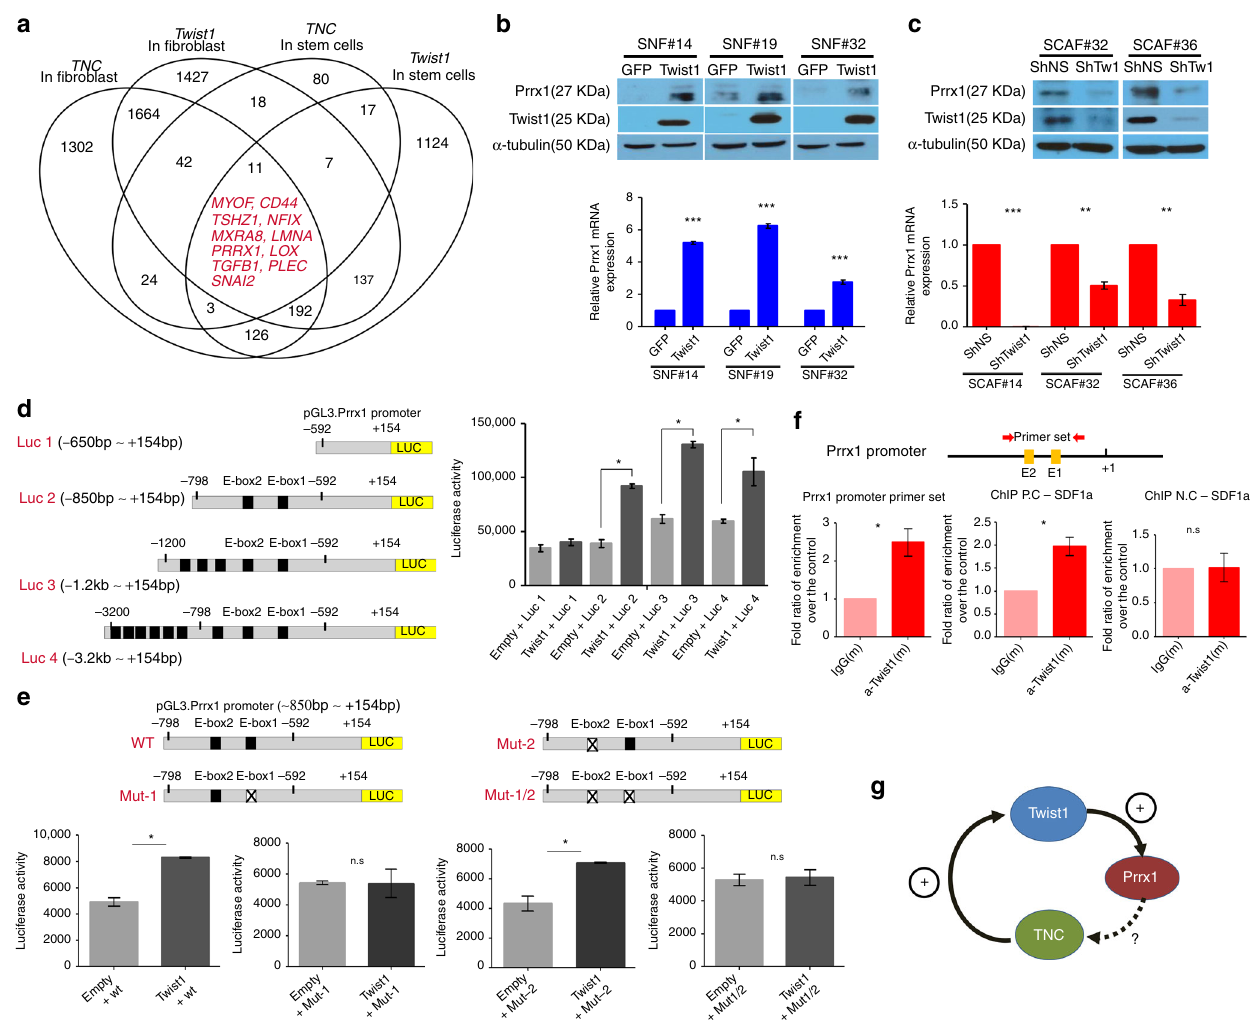
Fig. 2 Twist1 was an essential, positive transcriptional regulator of Prrx1 expression in both normal fi broblasts and CAFs. Twist1 enhanced the expression of Prrx1, a potential TNC inducer, by direct transcriptional activation. a Analysis of the FANTOM database revealed 11 candidate genes whose expressions were signi fi cantly correlated with both Twist1 and TNC expression in fi broblasts and stem cells. b Induction of Twist1 expression increased Prrx1 expression in normal fi broblasts. c The knockdown of Twist1 expression in CAFs led to decreased Prrx1 expression. Data are presented as the mean ± SEM; N = 3 independent experiments (two-tailed t test: ** p <0.001, *** p <0.0001). d To determine whether Twist1 regulates Prrx1 promoter activity, Prrx1 promoter- driven luciferase gene and Twist1 expression vector were cotransfected into HT1080 fi brosarcoma cells. The luciferase reporter assay revealed that the ectopic expression of Twist1 increased the Prrx1 promoter activity. Of the four different Prrx1 promoter constructs, construct #2 containing two E-boxes between − 798 and − 592 bp from the TSS of Prrx1 showed the most obvious difference in response to transient cotransfection with a Twist1 expression vector. Data are presented as the mean ± SEM; N = 3 independent experiments (two-tailed t test: * p <0.001). e Two E-box mutations in E-box 1 (CATCTG ( − 619) to GGTCTG) and E-box 2 (CAACTG ( − 787) to TCACTG) were introduced in HT1080 cells. The Twist1-induced Prrx1 promoter activity was negated by the E-box mutation that was located at 619 bp of the TSS of Prrx1. Data are presented as the mean ± SEM; N = 3 independent experiments (two-tailed t test: * p <0.05). f The schematic illustration of the ChIP assay PCR primer binding sites in the Prrx1 promoter region. We used the E-box sequence in the SDF1a promoter as a positive control. Compared with the IgG and positive controls, the Prrx1 promoter region that contained E-box 1 and E- box 2 was speci fi cally enriched by each primer set after chromatin immunoprecipitation. That is, the ChIP assay revealed that Twist1 binds to the Prrx1 promoter sites ( − 819 to − 597 bp) that contain two E-boxes. Data are presented as the mean ± SEM; N = 3 independent experiments (two-tailed t test: * p <0.05). g Schematic diagram of the regulatory relationship among Twist1, Prrx1, and